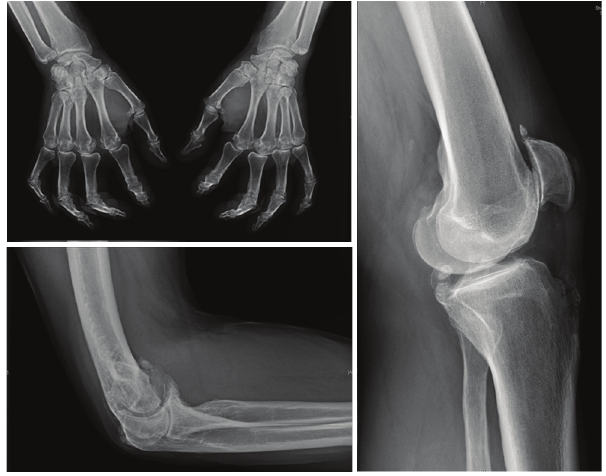
Figure 3: Metacarpal heads osteophytes, MCPs subluxations, and joint narrowing; calcifications of patella and